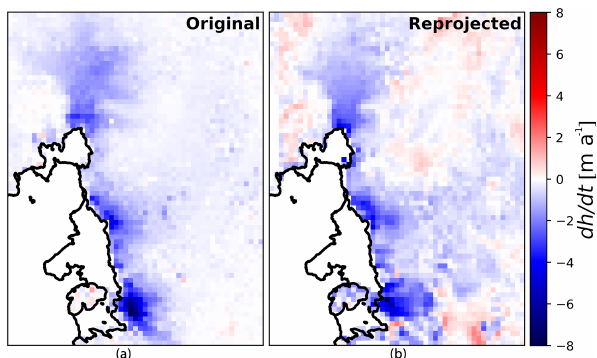
Figure 3. (a) Mean observed ice thickness change from 2008 to 2015 based on data from Konrad et al. (2017). (b) As (a) but pro- jected to first five PCs and reprojected to spatial